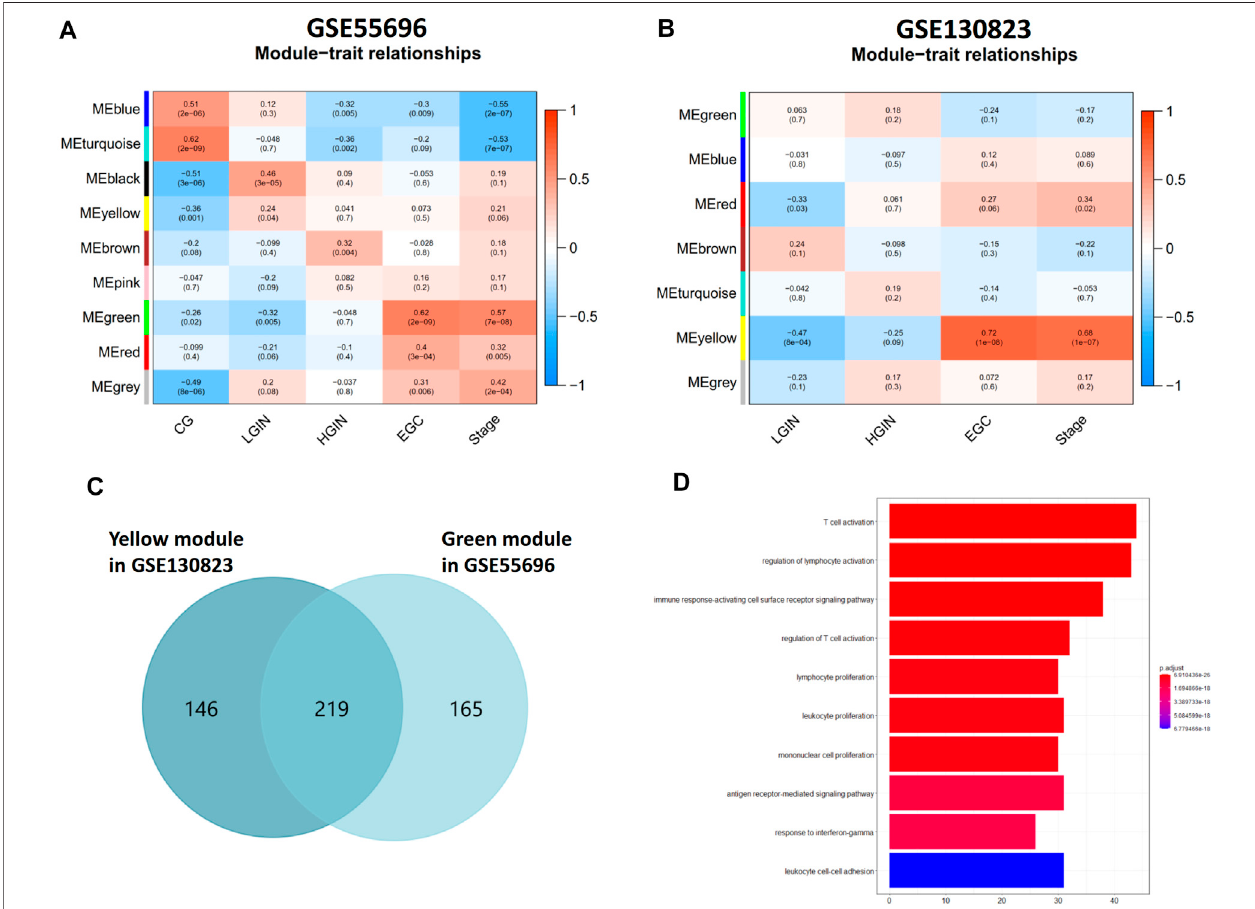
FIGURE 1 | Identi fi cation of key gene modules associated with GPL progression to EGC. (A, B) Module-trait relationships in the GSE55696 cohort and GSE130823cohort.Eachrowcorrespondstoacolormodule,andeachcolumncorrelatestotheclinicaltrait. (C) Venndiagramshowing219intersectiongenesfromthe green module in GSE55696 and the yellow module in GSE130823, which were regarded as keygene modules associated with GPL progression to EGC. (D) Resultsof GO enrichment of the 219 intersection genes.